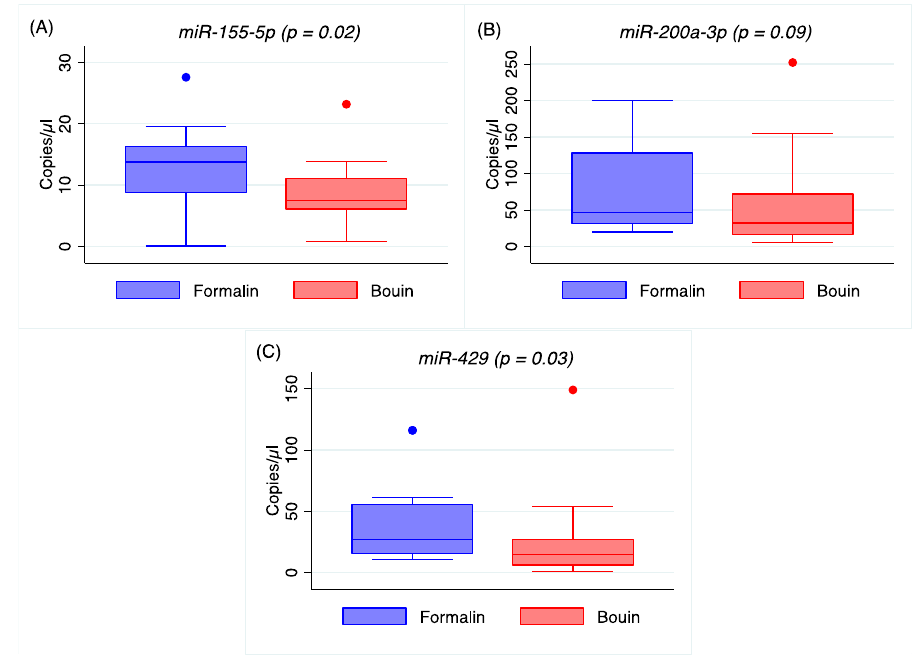
Figure A3. Box plot representing quantitative reverse transcription polymerase chain reaction (RT/ddPCR) of miR-155-5p ( A ), miR-200a-3p ( B ), and miR-429 ( C ) in matched formalin- and Bouin’s-fixed tissues by ddPCR. The box represents the first and third quartiles, intersected by the median, and the whiskers are the range.